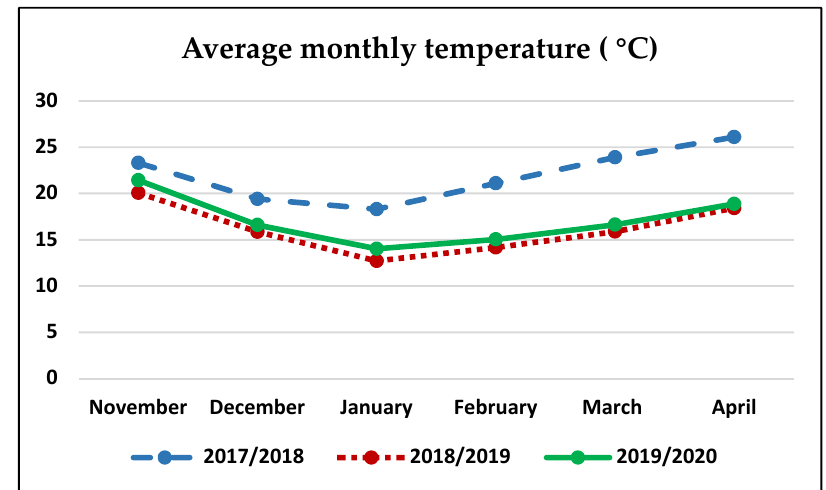
Figure 1. Average monthly temperature (°C) for the three experimental seasons.